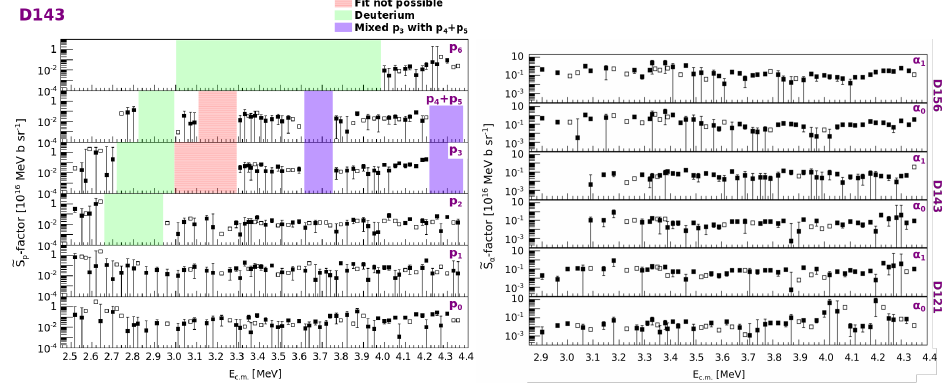
Figure 3. Di ff erential S -factors for individual proton groups obtained with detector D143 (left) and for individual α -particles obtained at all three angles (right). Figures taken from [20] and its supplemental material (published under a Creative Commons Attribution 4.0 International